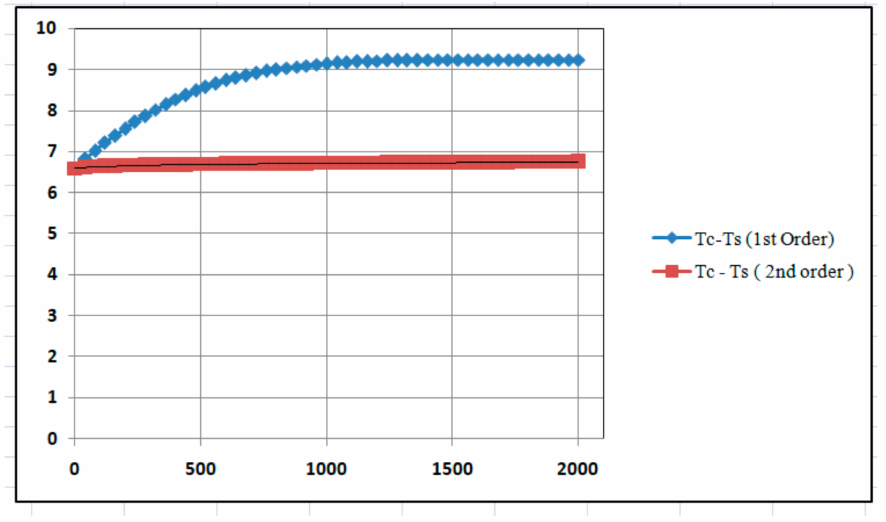
Figure 20. Comparison between T c - T s for higher C